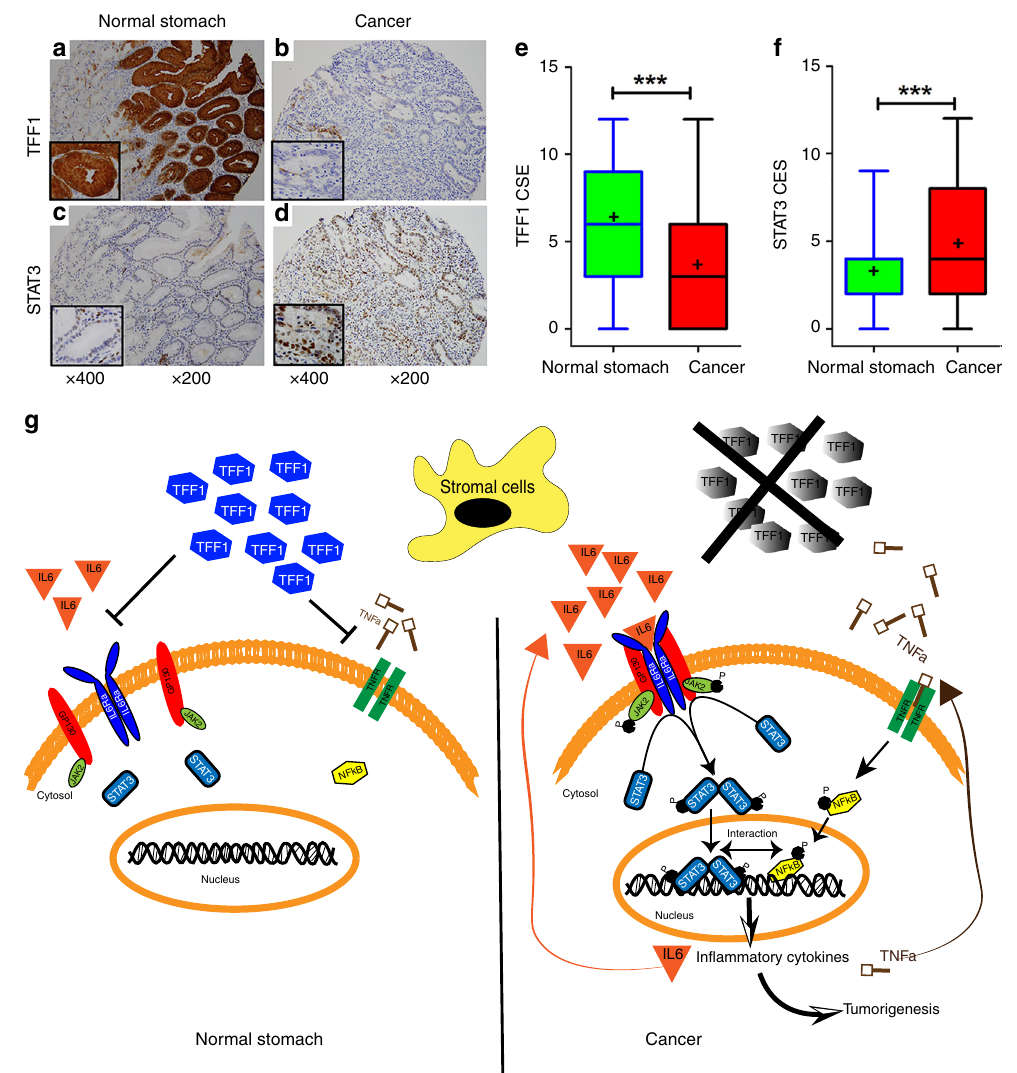
Fig. 9 Human gastric cancer tissues demonstrate nuclear localization of STAT3 and loss of TFF1. a – f Representative immunohistochemical (IHC) staining images of TFF1 (upper panels a and b ) and STAT3 (lower panels c and d ) using human gastric cancer tissue microarrays that contained 108 cancer samples with their matching adjacent histologically normal stomach, original magni fi cation is at ×200 and insets are at ×400. e , f Summary graphs of the IHC staining of TFF1 ( e ) and nuclear STAT3 ( f ) results using box-and-whisker blots to depict the smallest value, lower quartile, median, upper quartile, and largest value, ( + ) indicate the mean. g Schematic cartoon representing the role of trefoil factor 1 (TFF1) in regulating in fl ammatory signaling in gastric epithelial cells. Gastric cancer is associated with in fl ammation mediated by the release of cytokines such IL6 and TNF α from stromal and epithelial cells inducing activation of STAT3 and NF κ B transcriptional factors. Loss of TFF1 promotes IL-6-mediated IL6R α -GP130 complex formation, recruitment and phosphorylation of JAK2, with subsequent phosphorylation and nuclear localization of STAT3 to activate STAT3 transcription targets. The role of TFF1 in regulating NF κ B has been described before